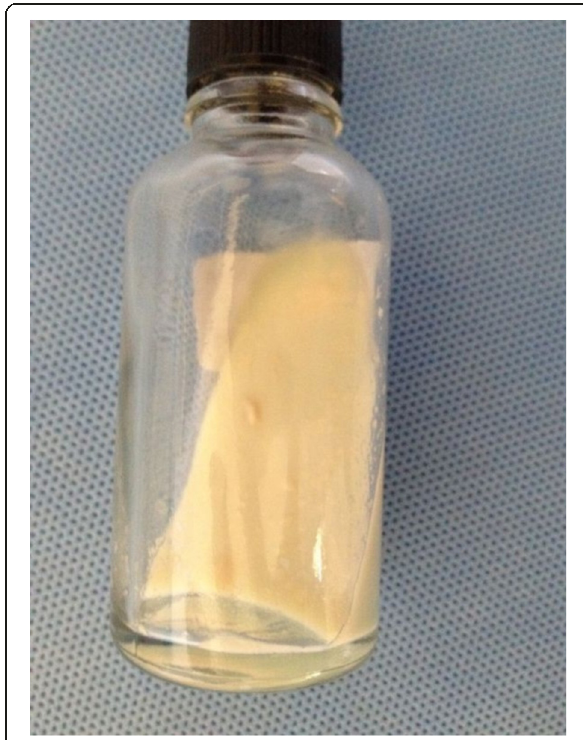
Figure 3 Mycobacterium marinum culture on Löwenstein-Jensen medium, after 12 days of incubation at 26°C